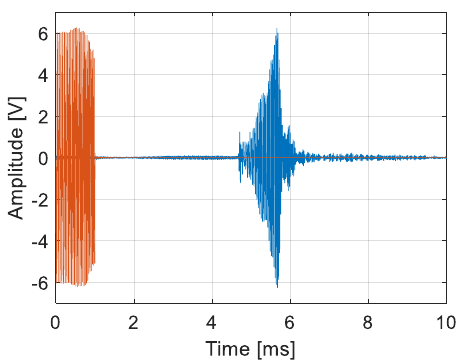
Figure 6. This plot shows in red an example of the chirp excitation signal that was applied to the ultrasonic transducers, and in blue, the received signal measured by the